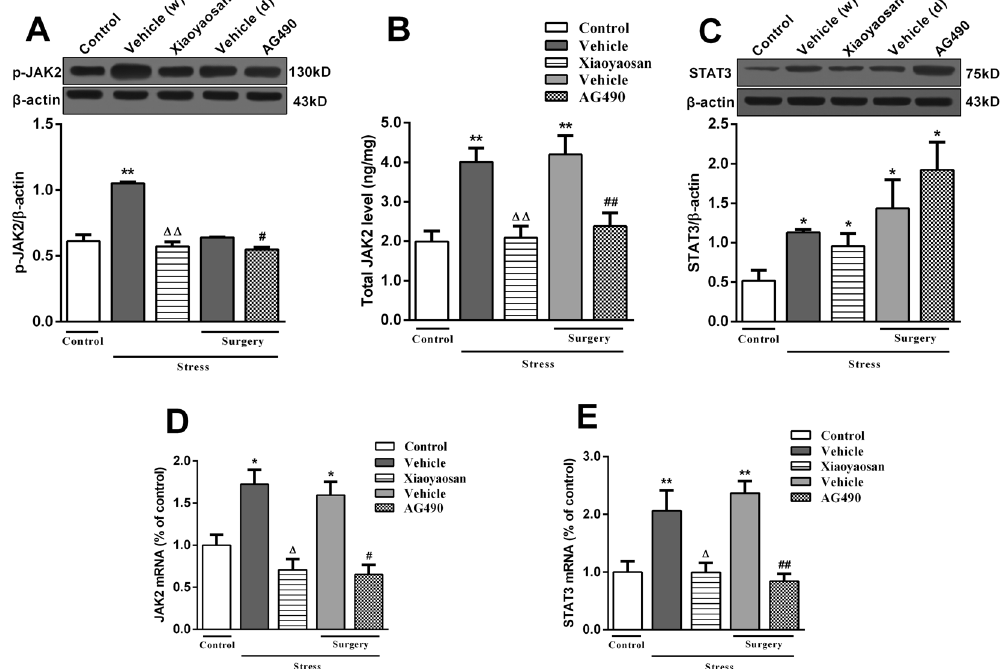
Figure 5. Effects of Xiaoyaosan on the JAK2-STAT3 signalling pathway in the rat hippocampus. ( A ) Expression of the p-JAK2 protein in the rat hippocampus. ( B ) Total JAK2 levels in the rat hippocampus. ( C ) Expression of the STAT3 protein in the rat hippocampus. ( D ) Expression of the JAK2 mRNA in the rat hippocampus. ( E ) Expression of the STAT3 mRNA in the rat hippocampus. Values are presented as the means ± SEM from 3–4 rats per group for determination of the expression of the p-JAK2 and STAT3 proteins, from 6 rats per group for the determination of total JAK2 levels, and from 5 rats per group for the determination of the expression of JAK2 and STAT3 mRNA in the rat hippocampus. * P < 0.05 or ** P < 0.01 versus the control group. Δ P < 0.05 or ΔΔ P < 0.01 versus the vehicle (distilled water) group. # P < 0.05 or ## P < 0.01 versus the vehicle (dissolvent)